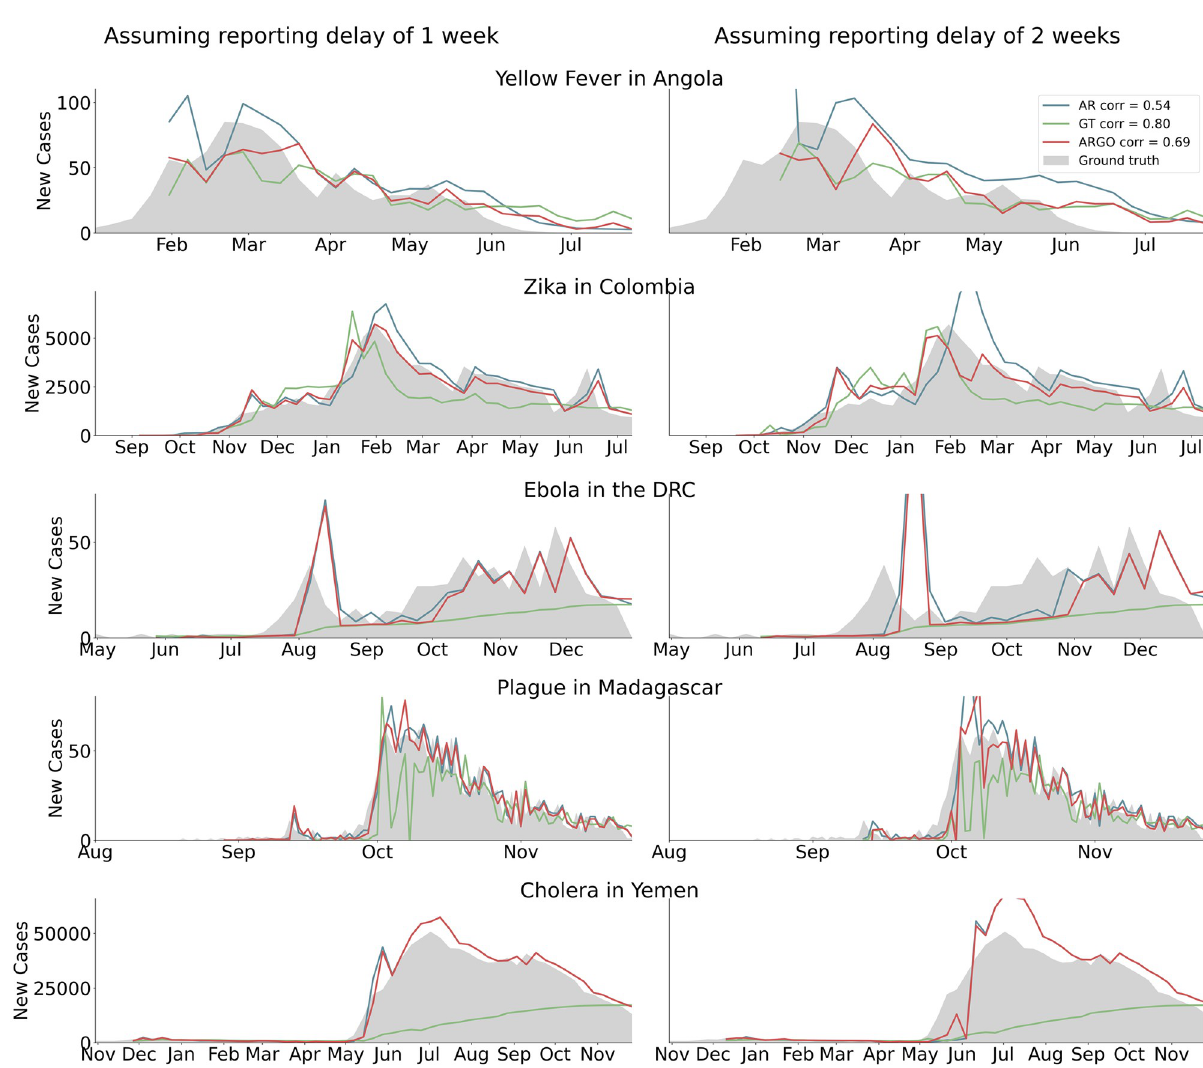
Fig 2. Series of plots comparing the nowcasts produced by three digital epidemiological models (available in real-time) to “ground truth” epidemiological data (available at a delay). The left column shows how models perform assuming a 1-week reporting delay in the traditional surveillance system; the right columns shows model performance assuming a 2-week reporting